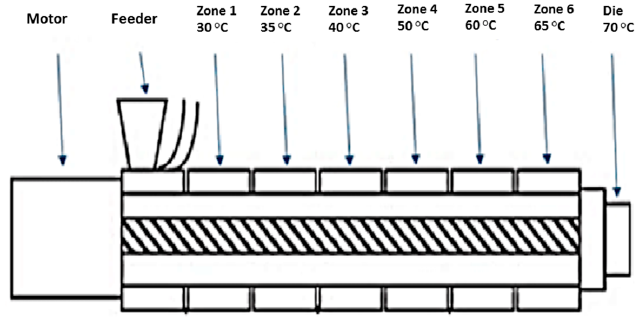
Figure 1. Schematic illustration of the APV twin-screw extruder and extrusion conditions used to compound SSB ® 55 pharmaceutical-grade shellac.